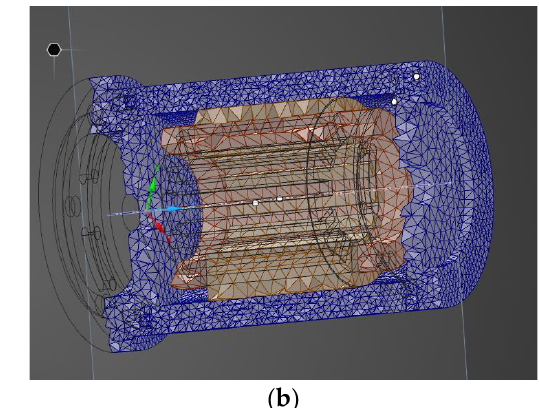
Figure 12. SRM cooling setup schematic.